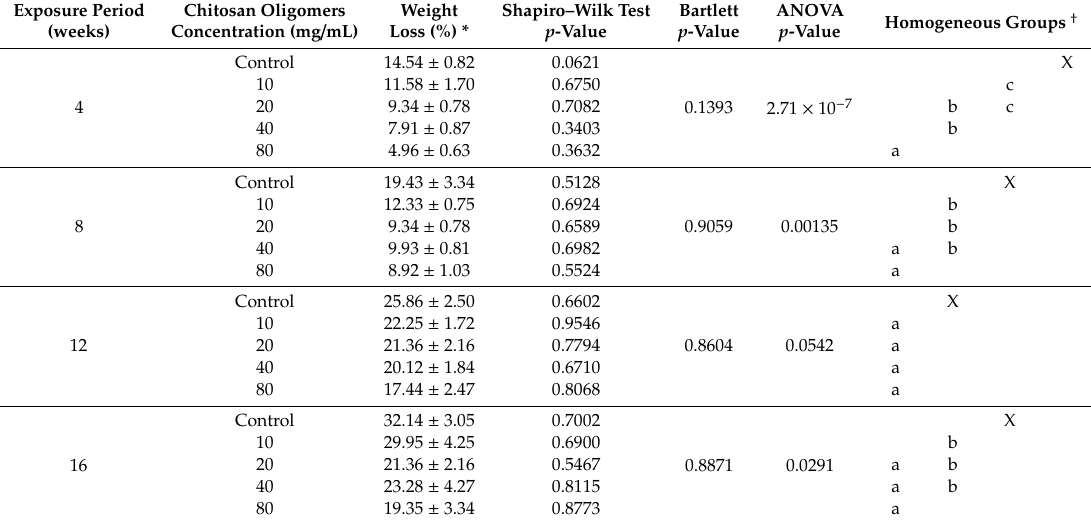
Table 3. E ff ect of chitosan oligomers concentration and fungus exposure time on the protection of poplar wood against Trametes versicolor . Exposure Period